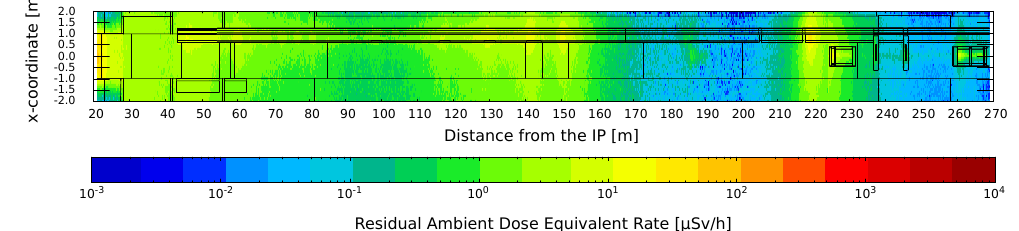
Figure 3. Projected radiation levels expected at LHC LSS1 at the end of the physics Run 3: 6 months cool down, LHC beam line elements